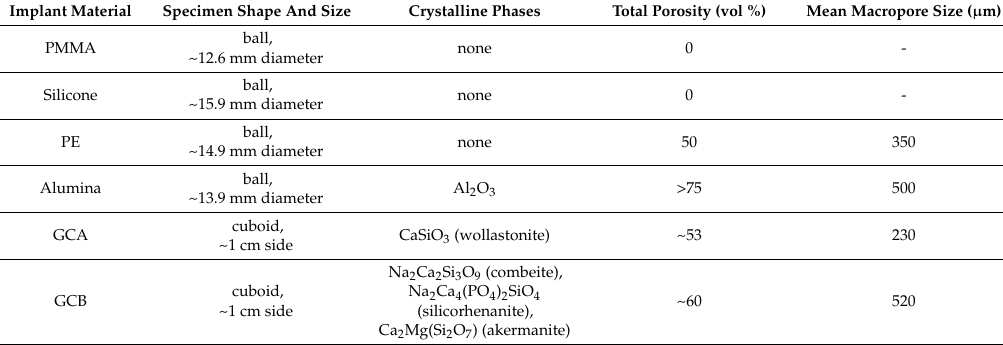
Table 1. Gross description of all the investigated materials, namely both the experimental implant materials GCA and GCB and the commercial implants selected as a reference (the two classes are separated by a continuous line). The major characteristics of implant materials (presence of crystalline phases, macropore size) come from product datasheet (for commercial implants) or previous assessment (for GCA and GCB [18]). PE: polyethylene; PMMA: poly(methyl